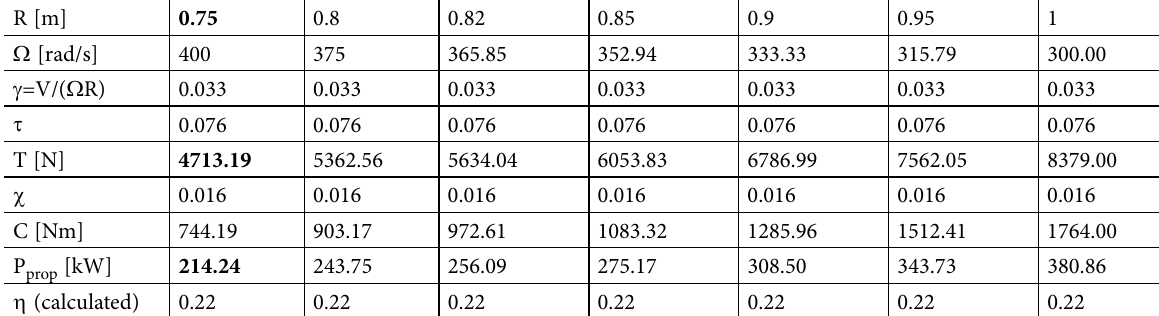
Table 2. Parametric study of propeller performances vs radius R with β = 20°